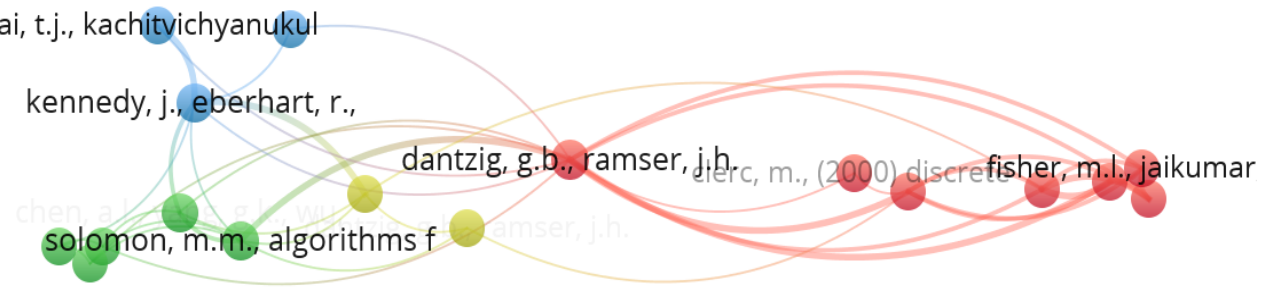
Figure 11. Co-citation reference network for the Scopus database search, five minimum citations [3,15,22,45–47]. Table 7. Key co-cited PSO/VRP documents from the Scopus query, n = 12/42.